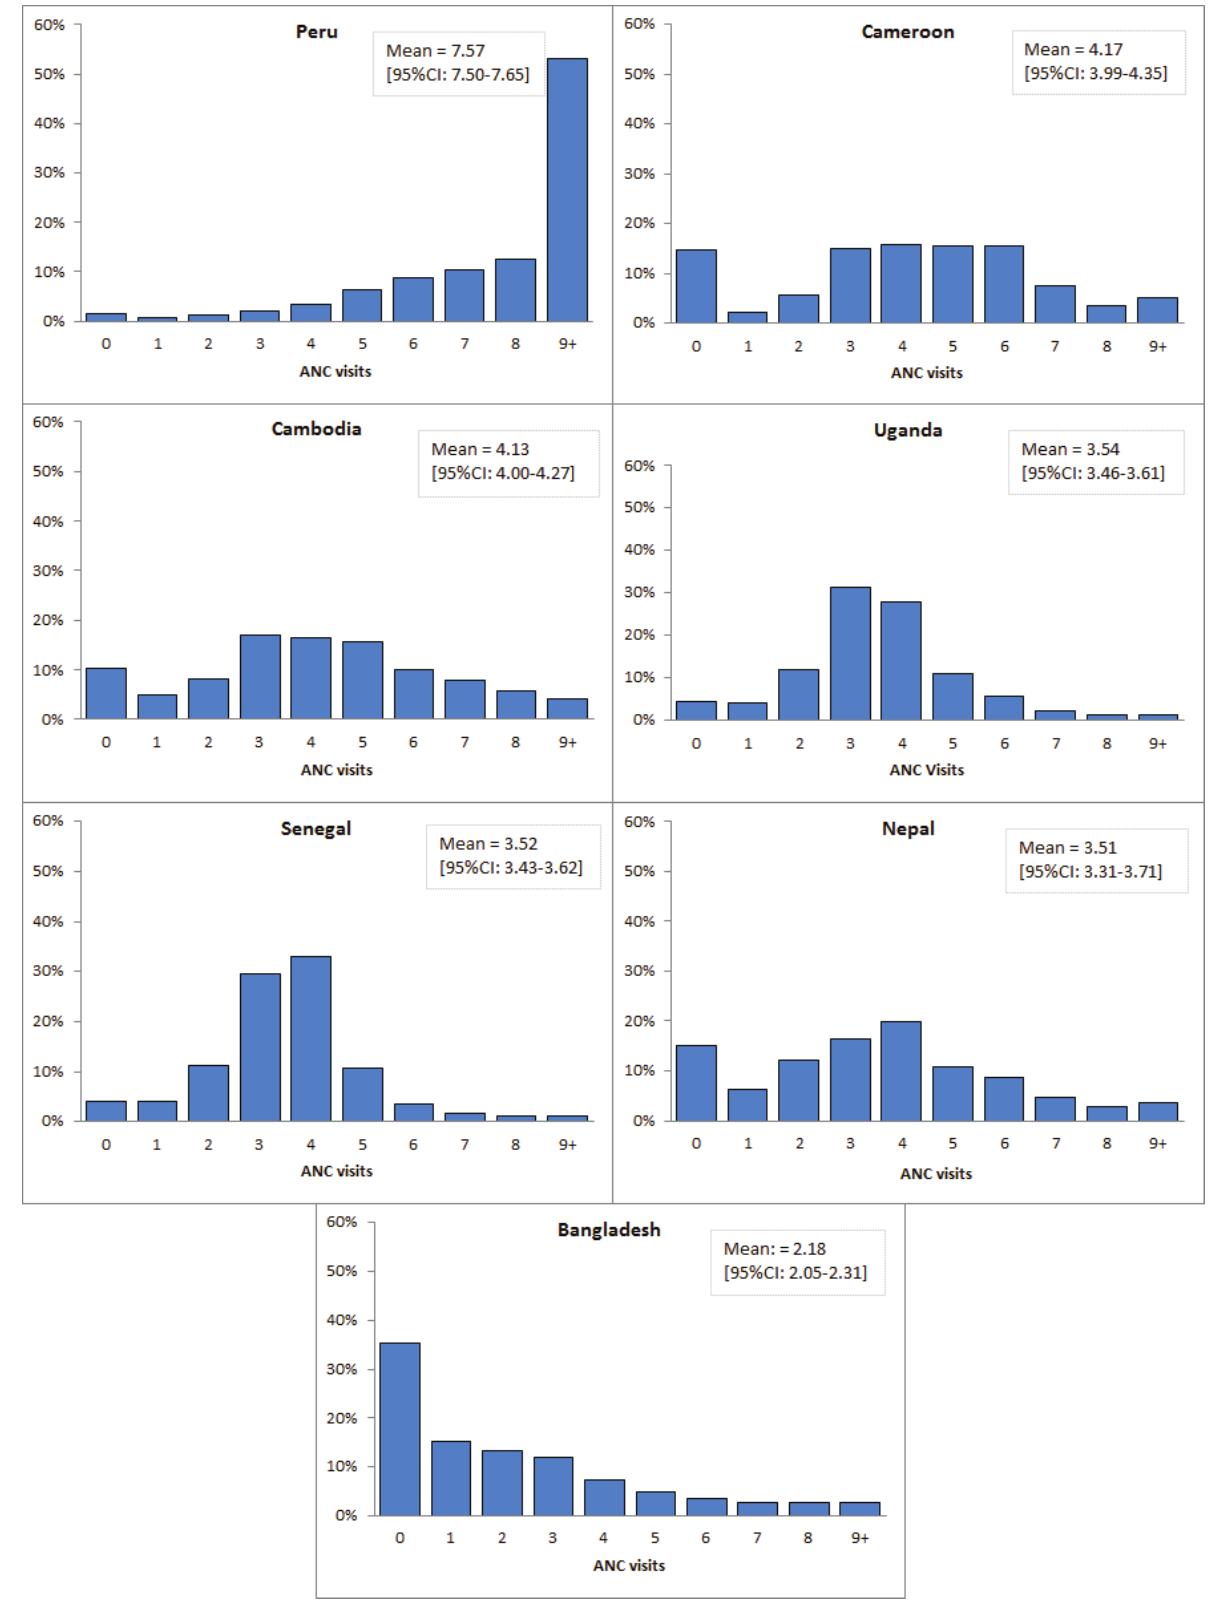
Figure 2. Percentage of women who had a live birth in the five years preceding the DHS surveys reporting zero to more than nine ANC visits for their most recent live birth, and mean of ANC visits among all these women (95% confidence intervals), in seven Countdown